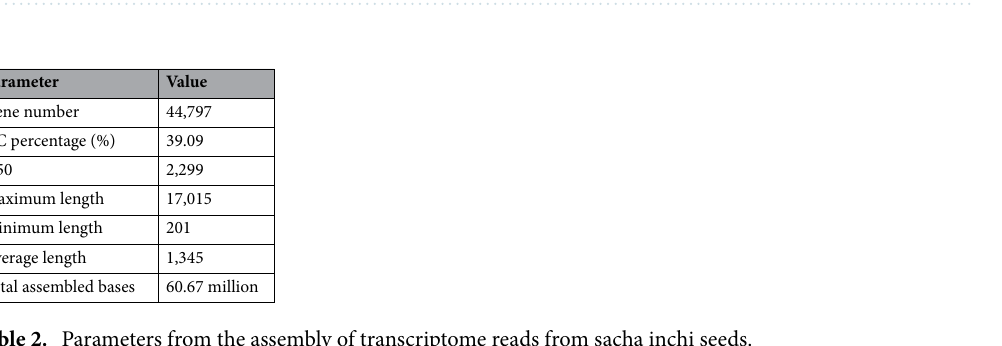
Table 1. Summary statistics of clean transcriptome sequencing data for the five stages of sacha inchi seed development. DAF days after flowering, Q20 percentage of bases with quality values larger than 20, GC guanidine and cytosine nucleotides as a proportion of all nucleotides (expressed as a percentage).